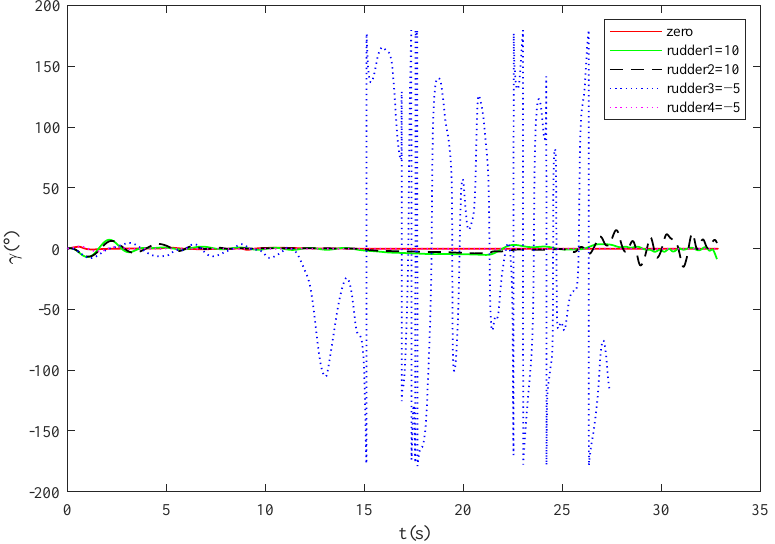
Figure 9. Roll angle response curve under steering gear